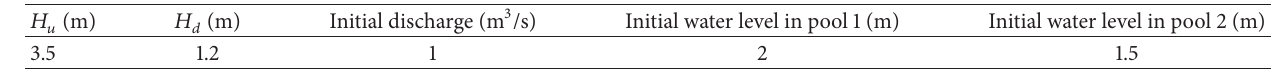
Table 4: Hydraulic conditions of each pool of the cascaded